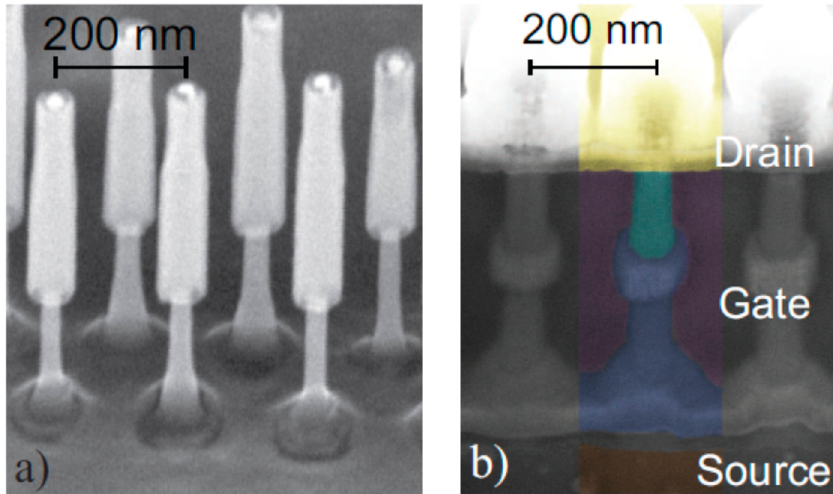
Figure 4. InAs vGAAFET formed by vapor-liquid-solid (VLS) bottom-up method: ( a ) Nanowires after thinning of channel regions and ( b ) final device structures with high-k metal gates [41].